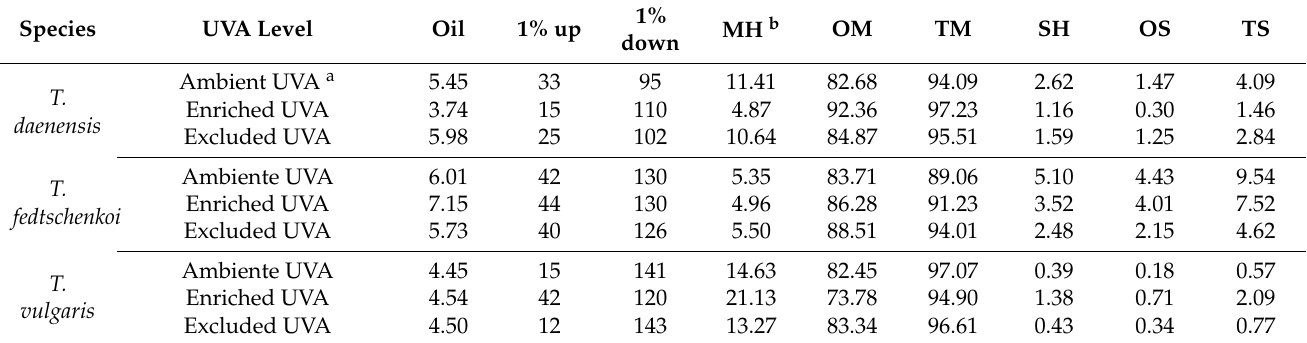
Table 4. Key total essential oil characteristics at each UVA level (ambient, enriched, excluded), regardless of the application with protectant compounds [water (control), melatonin, glutathione, iron-zinc nanofertilizer] in the three Thymus species under